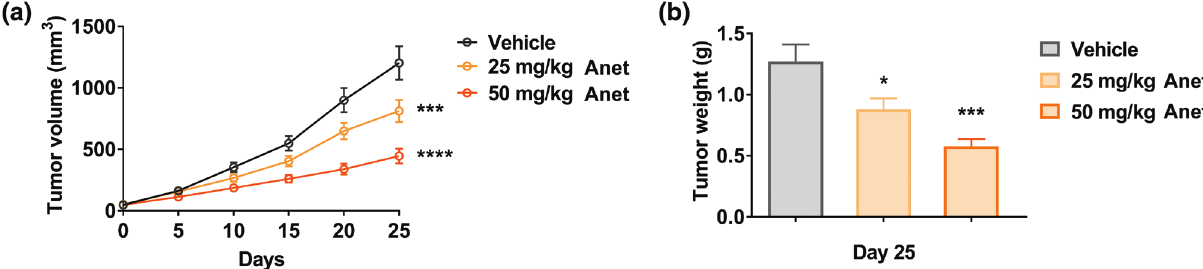
Fig. 5. Anethole inhibited the progression of A549 tumor in vivo . A549 tumor-bearing mice were treated by vehicle, 25, or 50 mg/kg anethole. The indexes of tumor volume (a) and weight at the end point (b) were measured. n = 7 for each group. Error bar represents SEM. * P < 0.05, *** P < 0.001, and **** P <